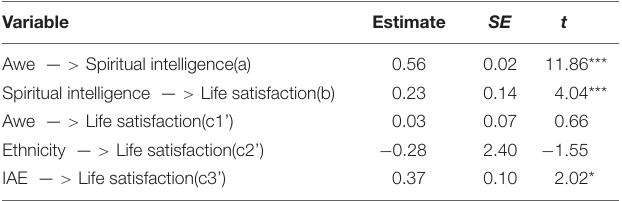
TABLE 4 | Path coefficient results for awe, ethnicity, spiritual intelligence, and life satisfaction. Variable Estimate SE t